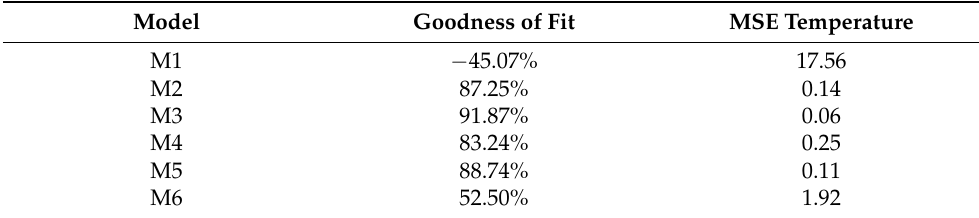
Figure 12. Comparison between identified models and the training dataset for the real building. Table 4. Goodness of fit and MSE for each identified model compared to the training dataset for the real building.